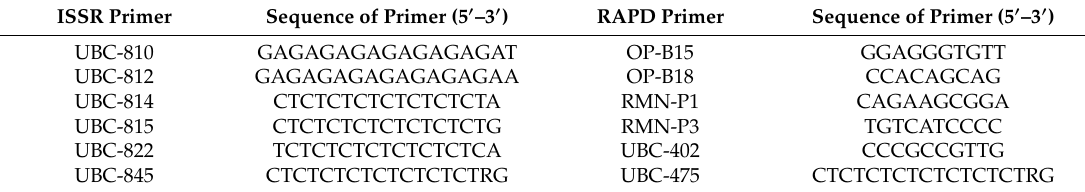
Table 2. Primers used and their annealing